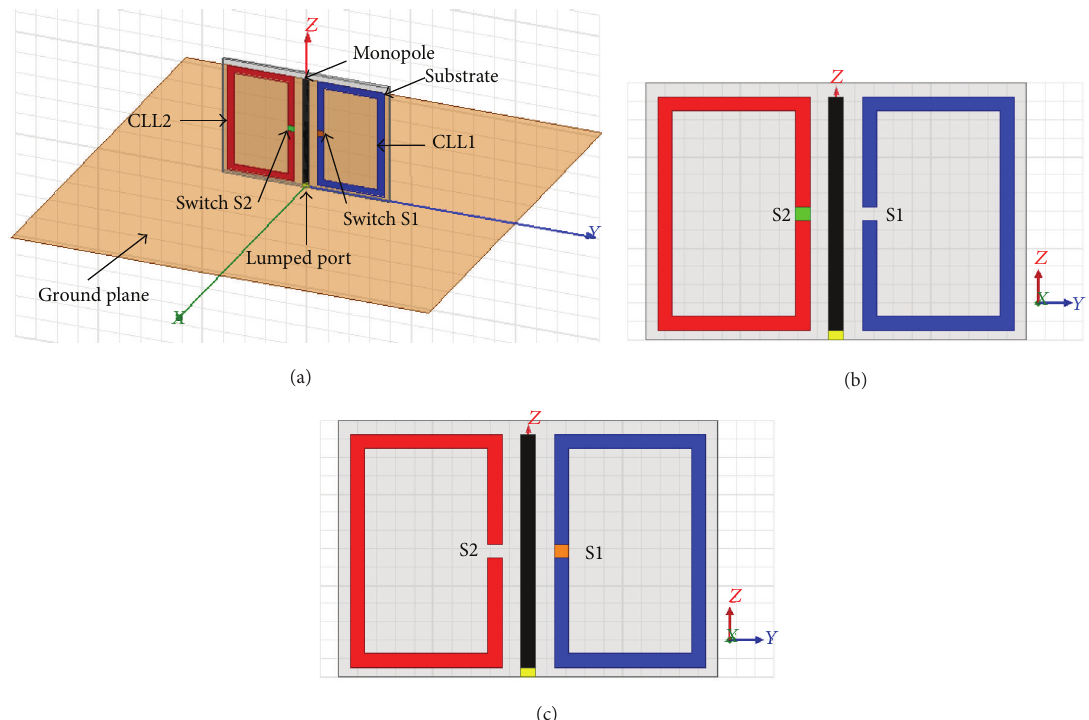
Figure 10: (a) Simulation model of the two-CLL element NFRP reconfigurable antenna, (b) State 1 (S1 is ON and S2 is OFF), and (c) State 2 (S2 is ON and S1 is